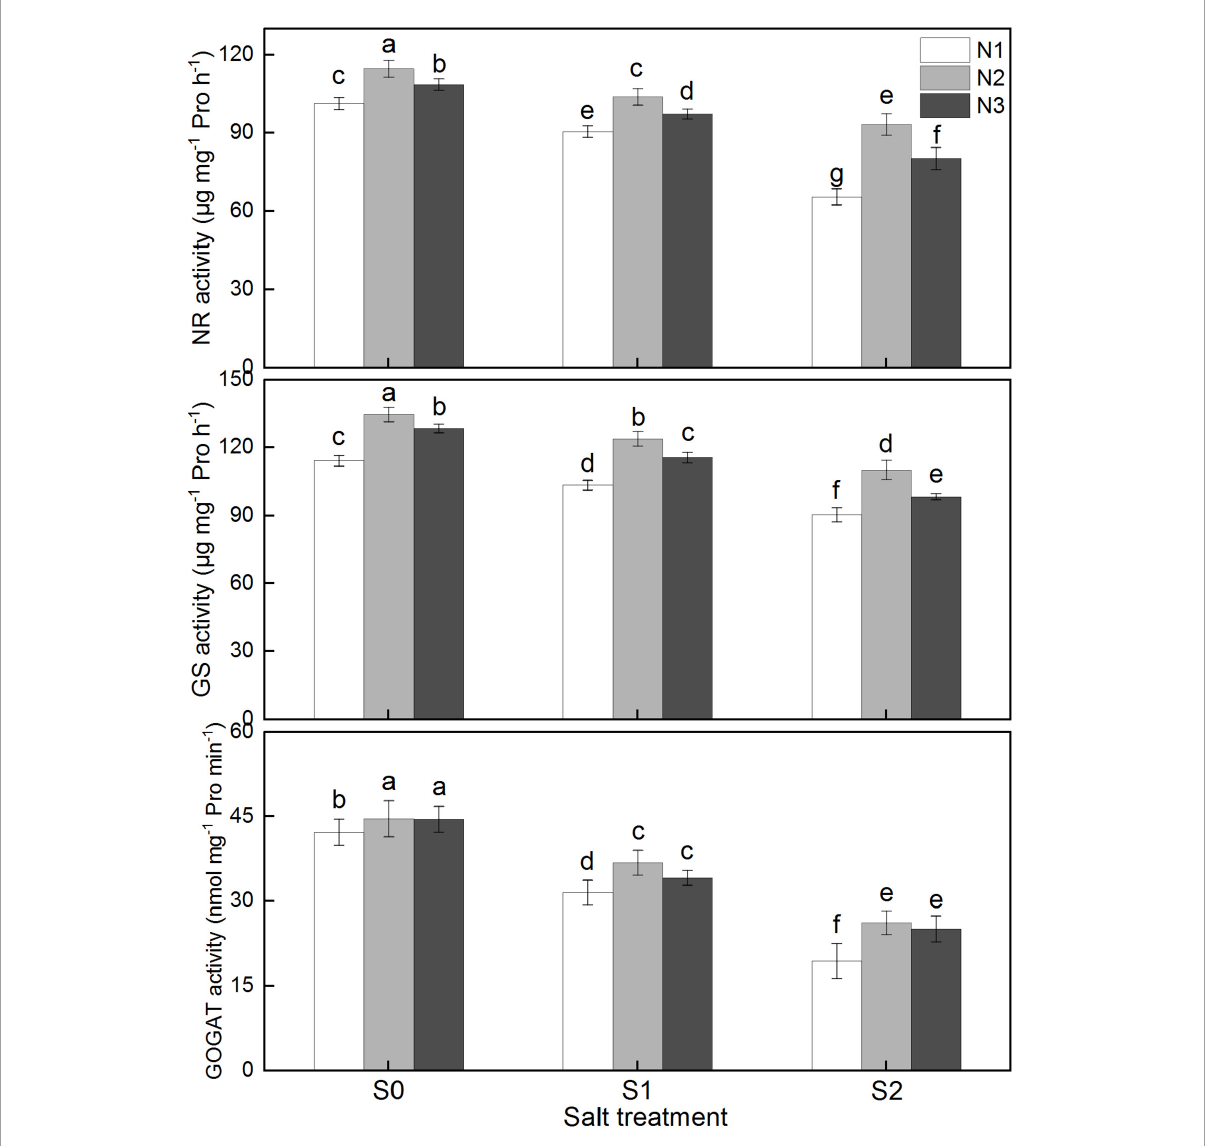
FIGURE6 Effects of different salt concentrations and nitrogen rates on NR, GS, and GOGAT activities in rice leaf at heading stage. S 0 , S 1 , and S 2 denote salt concentrations of 0, 1.5, and 3.0 g kg − 1 NaCl, respectively; N1, N2, and N3 denote nitrogen rates of 210, 300, and 390 kg ha − 1 . The data ( n = 3) are mean values ± SD, calculated from three independent experiments. The different letters indicate significant differences at P <